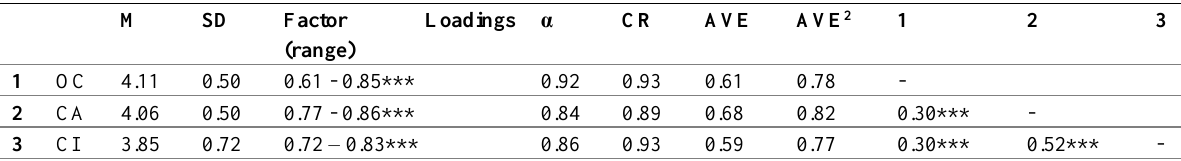
Table 1: Measurement test using confirmatory analysis on organizational climate (OC), career adaptability (CA) and career intention (CI) M SD Factor Loadings α CR AVE (range)